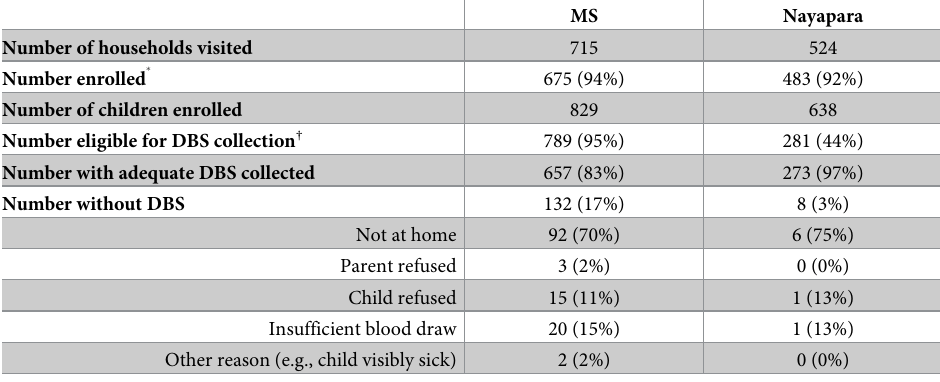
Table 1. Eligibility and enrollment of participants, serologic and vaccination coverage survey among Rohingya children, by geographic area, Cox’s Bazar, Bangladesh 2018.